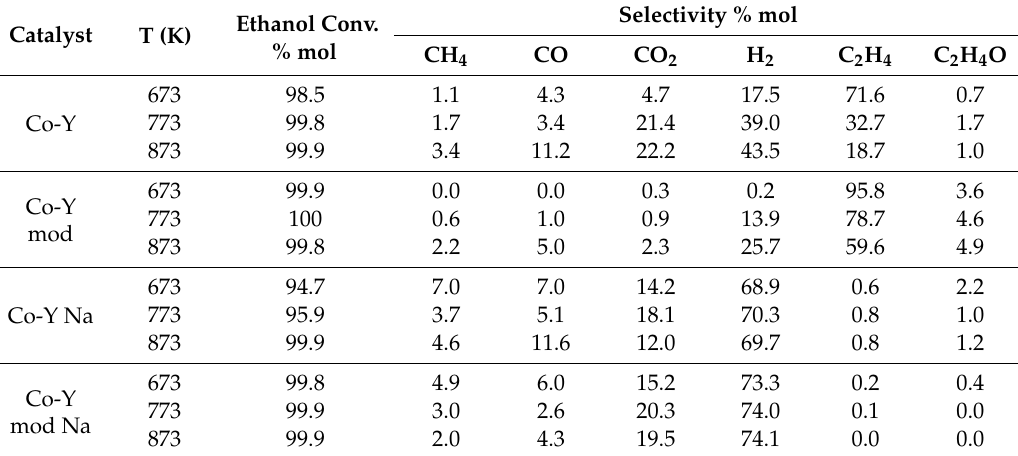
Table 4. Ethanol conversion and products selectivity in steam reforming of ethanol for the